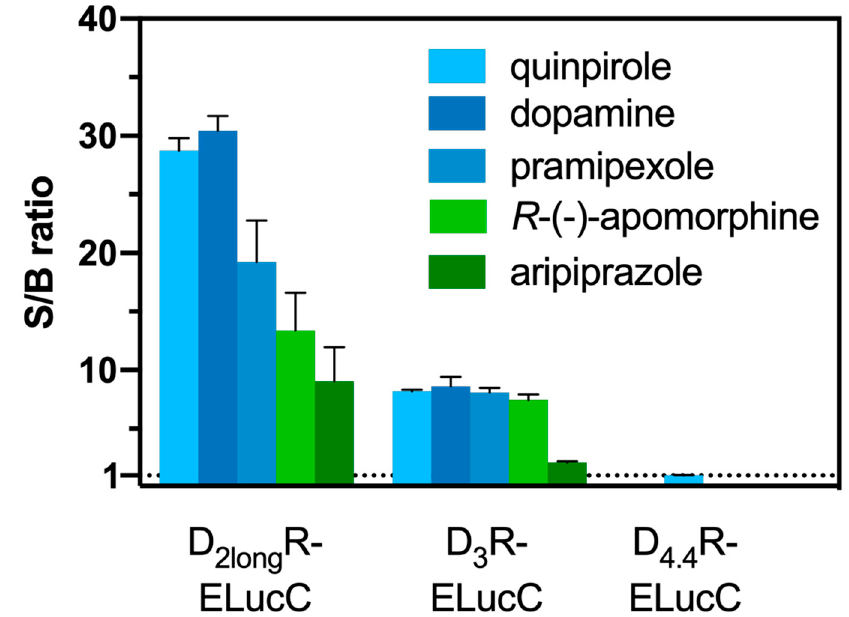
Figure 2. S / B ratios of the complemented ELuc after agonistic stimulation of the analyzed receptors. The cells were stimulated with various agonists (concentration corresponding to the estimated EC 80 value) and in case of the D 2long R the resulting AUC after 50 min was divided by the area obtained from a solvent control. S / B ratios of the D 3 R and the D 4.4 R were retrieved by dividing the luminescence after 90 min by that of a solvent control. Data represent means ± SEM from at least three independent experiments performed in triplicate.